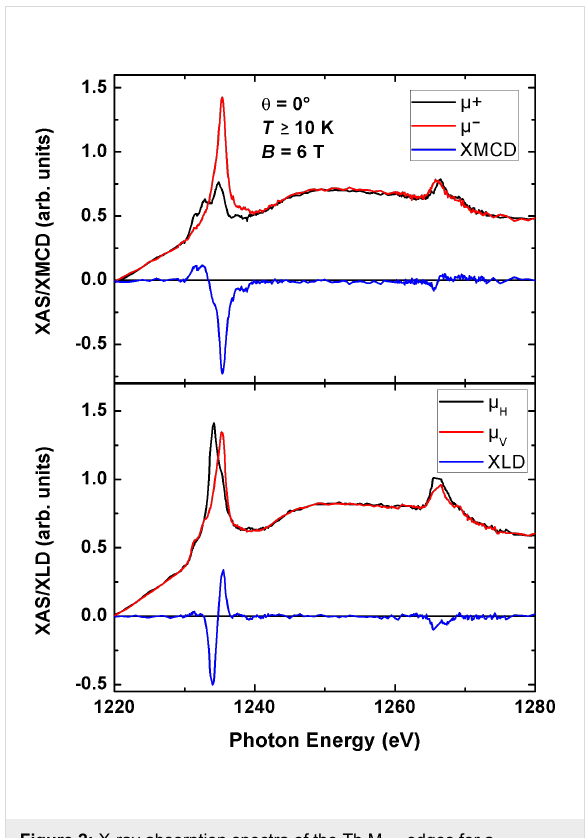
Figure 2: X-ray absorption spectra of the Tb M 4,5 edges for a submonolayer TbPc 2 /Cu(100), measured at T ≥ 10 K and B = 6 T. The top shows the spectra for circularly polarized X-rays (black and red) and the µ + − µ − = XMCD signal (blue) at perpendicular photon inci- dence (0°). The bottom figure shows the linearly polarized absorption spectra for an incidence angle of 45°. The red line corresponds to vertical polarization, where the electric field vector is parallel to the sample plane. The black line corresponds to horizontal polarization with an angle of 45° between the electric field vector and the sample surface. The blue line is the difference, i.e., the µ V − µ H = XLD